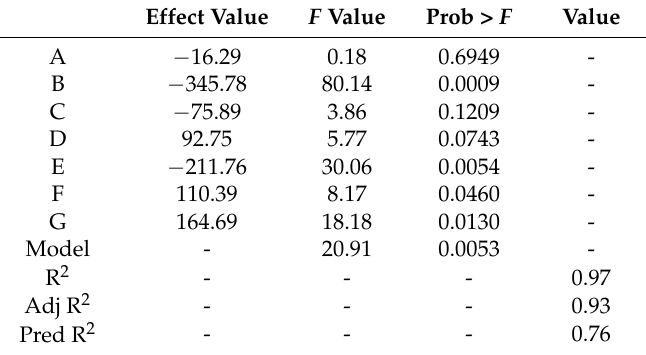
Table 1. Regression analysis for the selected Plackett–Burman (PB)